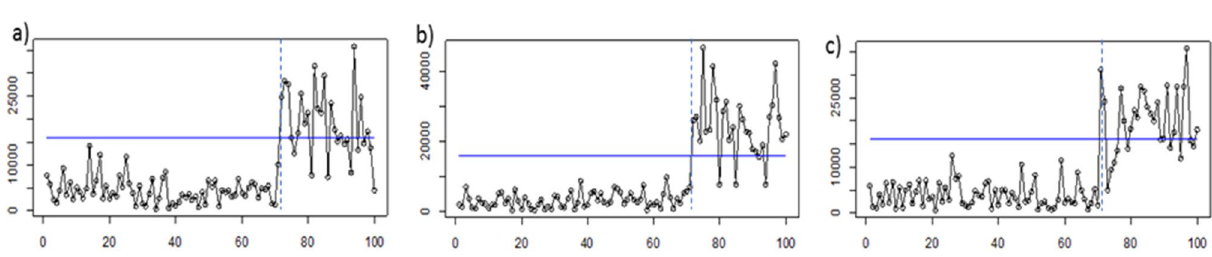
Figure 8. Application of the proposed Kernel PCA Mix chart with kernel Polynomial (1) for: ( a ) the first scenario, ( b ) the second scenario, and ( c ) the third scenario.